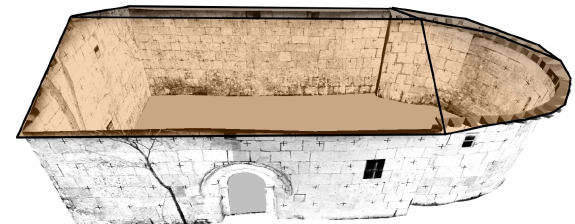
Figure 14. Ermitage of Andra Mari, original line drawing generated in 1996 (left) and model of surfaces derived of this drawing (left).